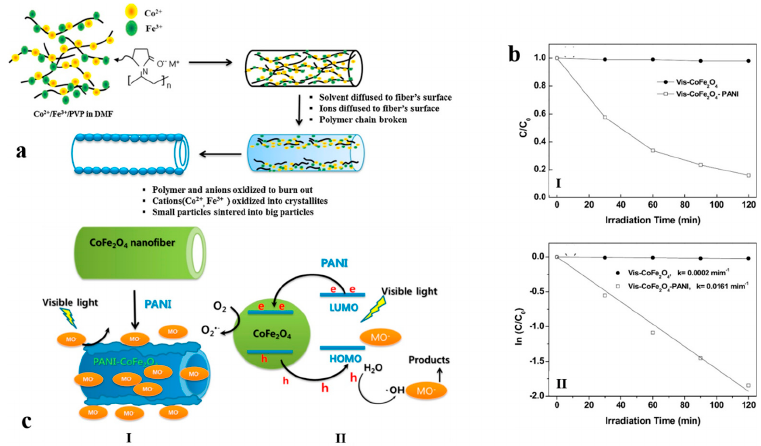
Figure 8. ( a ) Schematic illustration of the formation process of CoFe 2 O 4 hollow nanofibers; ( b ) (I) visible light photodegradation and (II) kinetic linear simulation curves of the methyl orange (MO) dye for CoFe 2 O 4 and CoFe 2 O 4 –PANI hollow nanofibers; ( c ) (I) schematic diagram and (II) mechanism of the photodegradation process by CoFe 2 O 4 -PANI hollow nanofiber when subjected to visible light (Reproduced with permission from [115]. Elsevier,